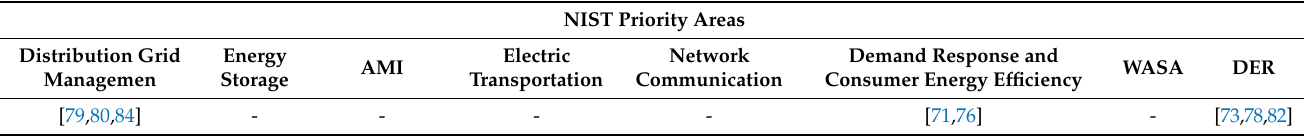
Table 5. Research on MAS-based trust in Smart Grid categorized based on NIST priority areas.